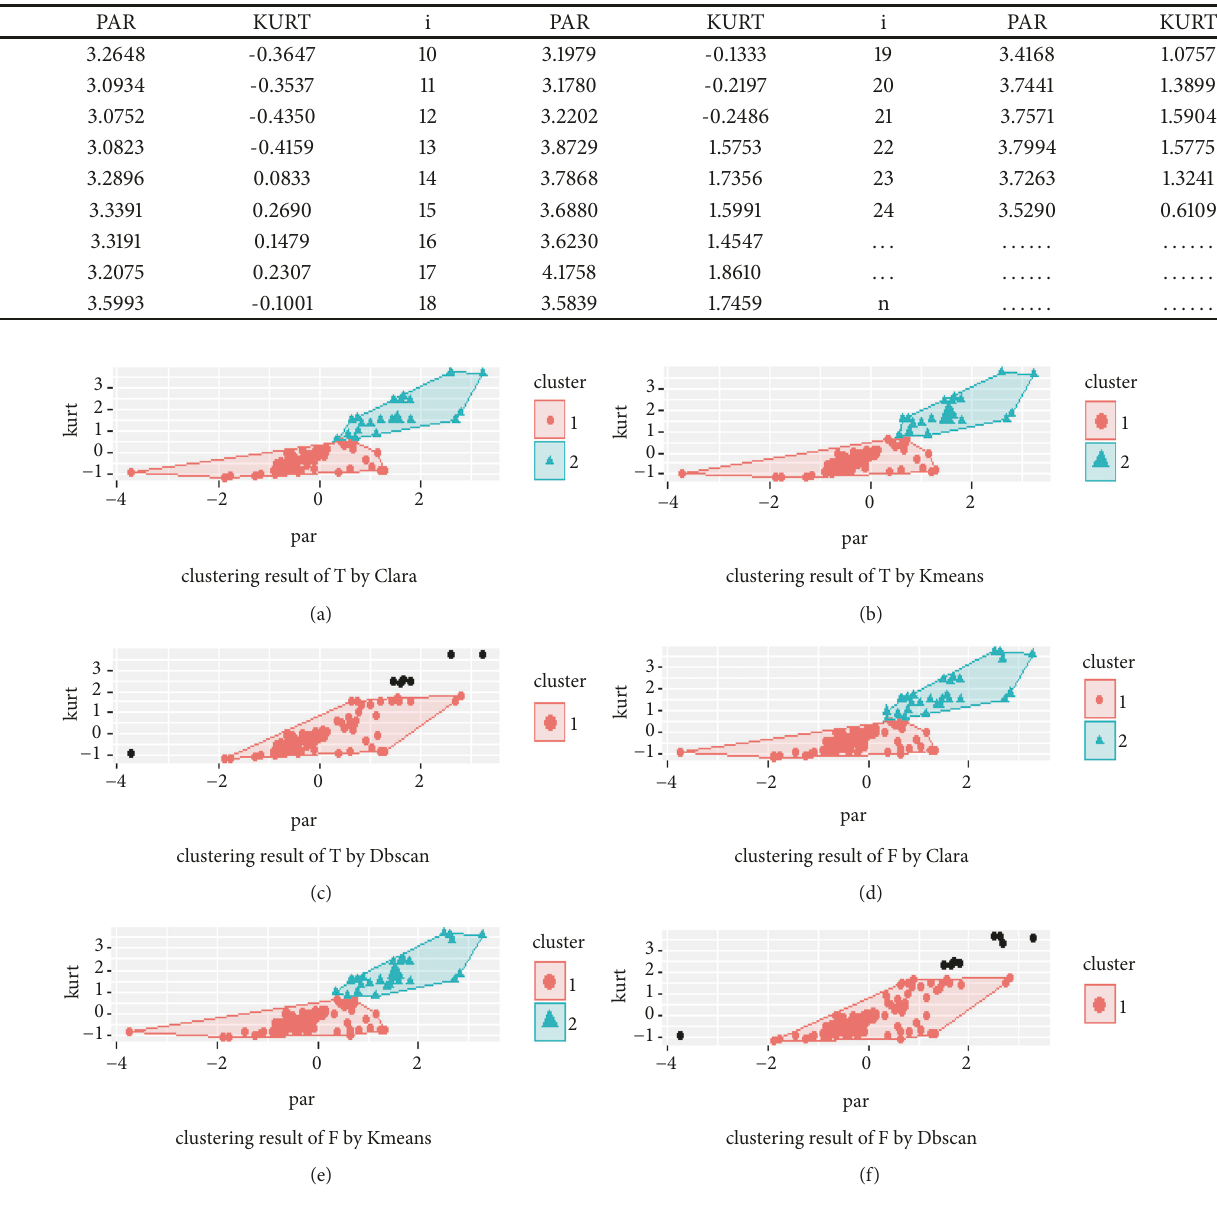
Figure 4: (a) Results of Clara clustering of T sets. (b) Results of Kmeans clustering of T sets. (c) Results of Dbscan clustering of T sets. (d) Results of Clara clustering of F sets. (e) Results of Kmeans clustering of F sets. (f) Results of Dbscan clustering of F